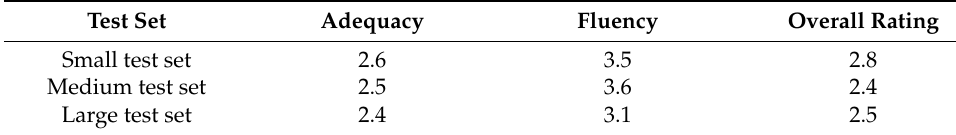
Table 10. Human assessment of NMT model 2.